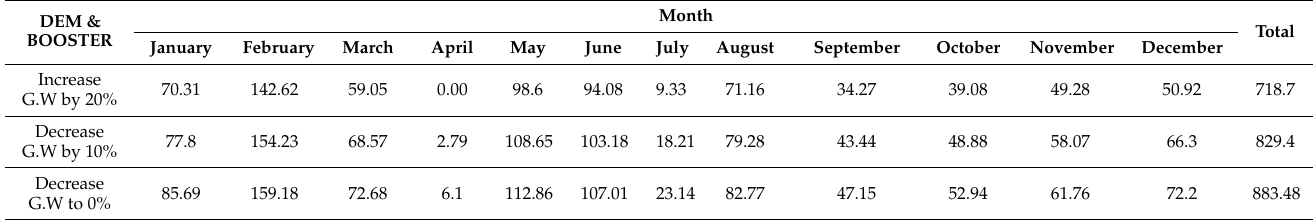
Figure 19. Monthly unmet demands (MCM) resulting from the effect of groundwater. Table 16. Monthly unmet demands (MCM) resulting from the effect of groundwater. Table 17 and Figure 20 show the comparison between the base case and different cases.